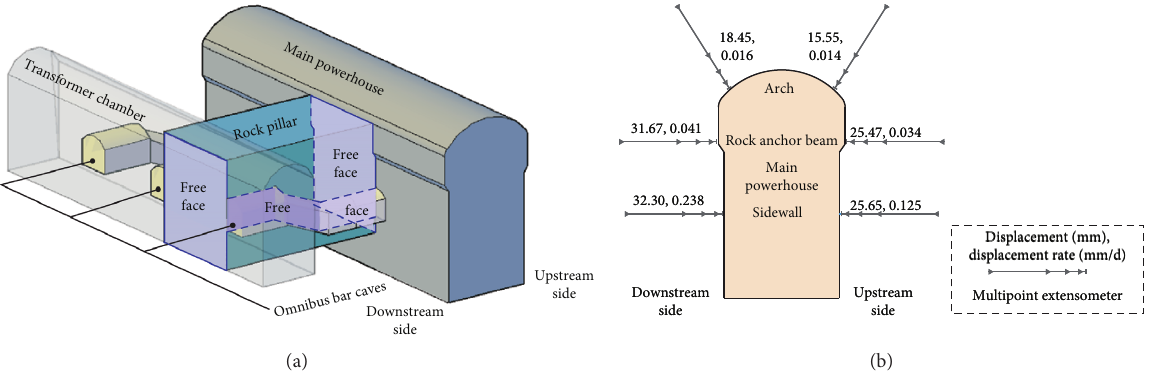
Figure 8: (a) The rock pillar between the main powerhouse and the transformer chamber with multiple free faces and (b) the average displacement and displacement rate of different parts of the main